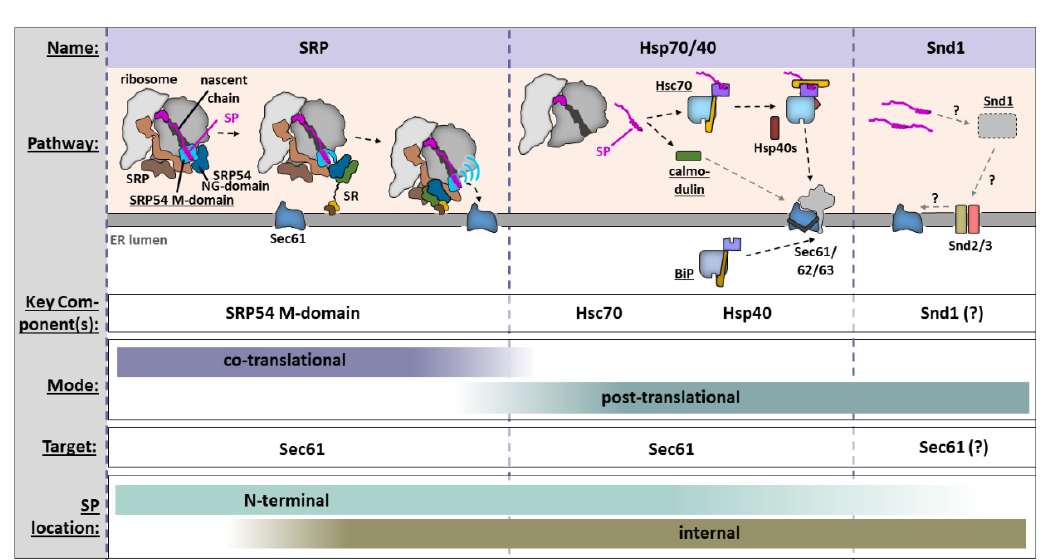
Figure 2. ER delivery pathways for SP-containing proteins. The upper panel shows a schematic of each delivery pathway. The central component of each pathway is underscored. Left: SRP (blue/brown subunits) recognizes SPs emerging from the ribosomal exit tunnel and shields them through the SRP54 M-domain. SP binding triggers the heterodimerization of the SRP54 NG domain (blue) with that of SR α (green), guiding the RNC to the ER. A large conformational rearrangement partially exposes the SP for handover to Sec61 [14]. Middle: Cytosolic calmodulin or Hsp40-assisted Hsc70 recognize SP-containing proteins and guide them to the ER. Right: The recently discovered Snd pathway likely consists of a cytosolic component, Snd1, which might act as a chaperone, and two ER membrane-resident components, Snd2/3, which might facilitate handover to Sec61 in some unknown way [15,16]. Lower panels show specifics of each pathway.